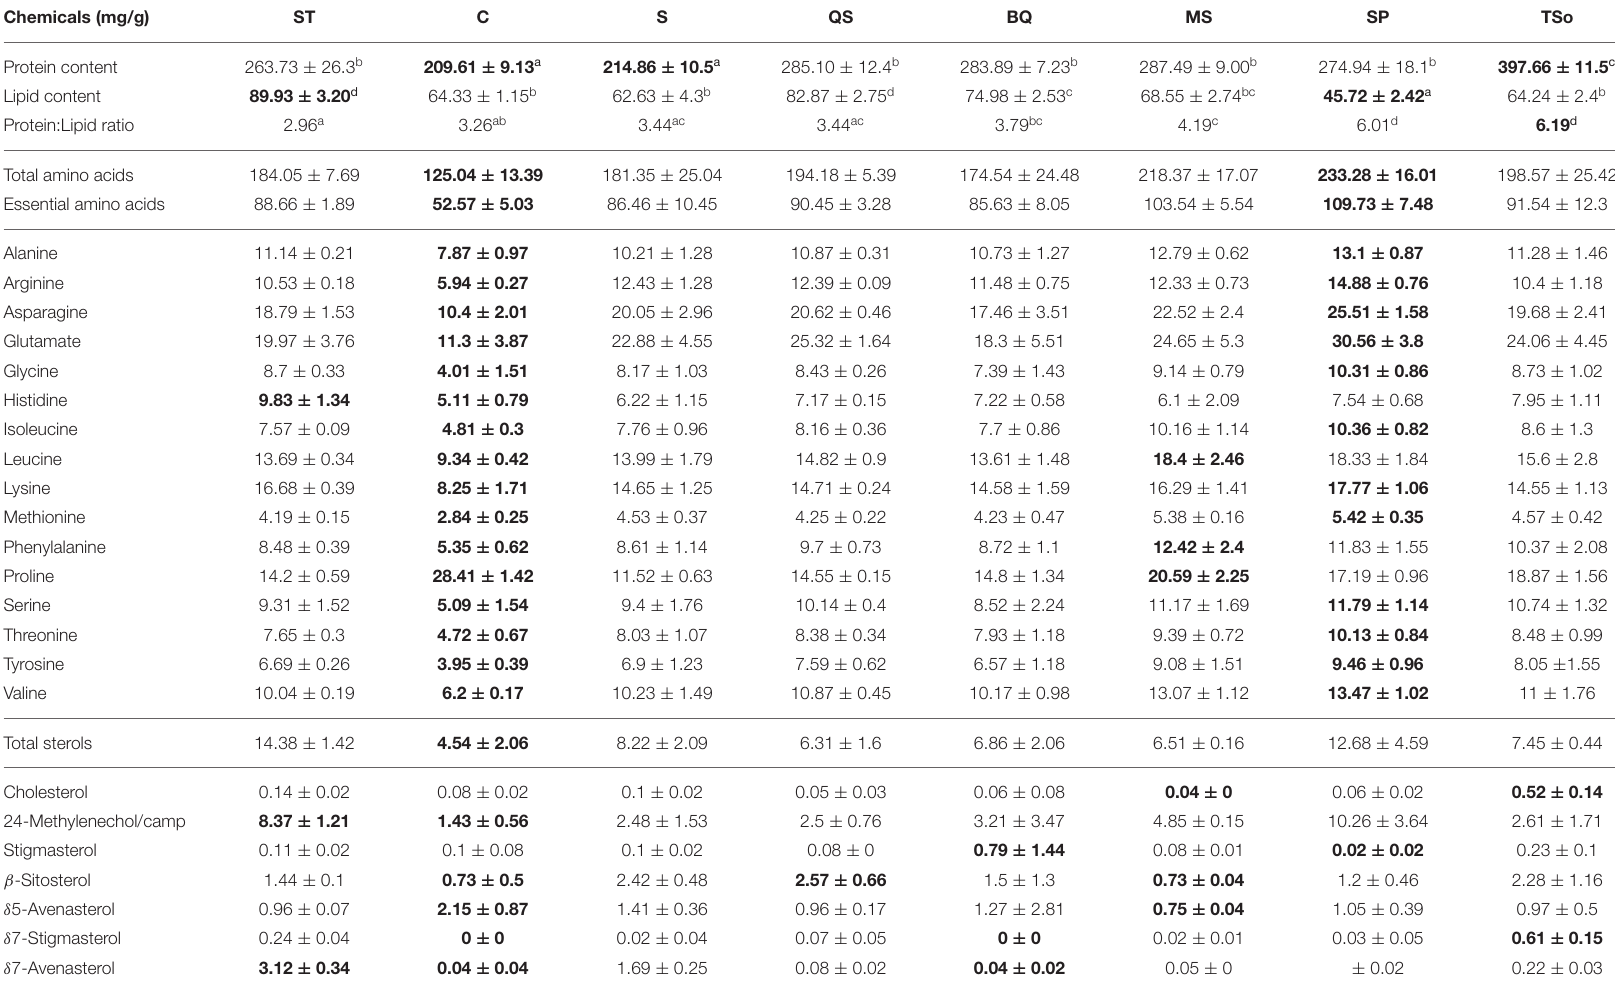
Mean values are presented with their standard deviation. Maximum and minimum values for each chemical are in bold as indicative. Different letters indicate significant differences (Kruskal-Wallis tests followed by Dunn’s multiple comparison tests, p <